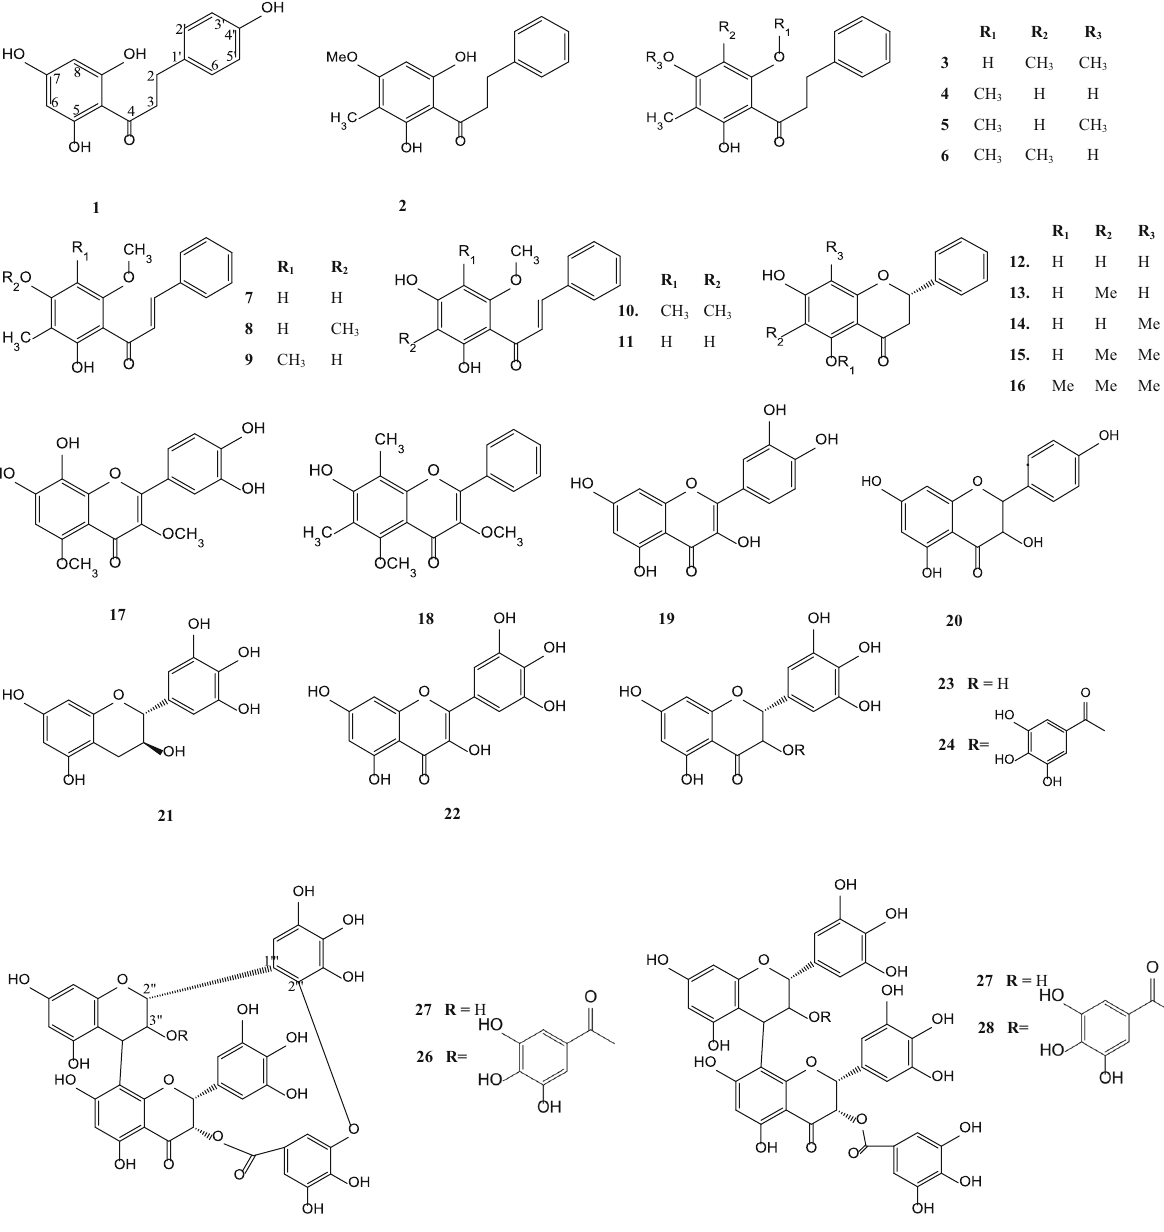
Figure 1: Flavonoids from various parts of S. aqueum , S. samarangense , S. aromaticum , S. cumini and S. guineense